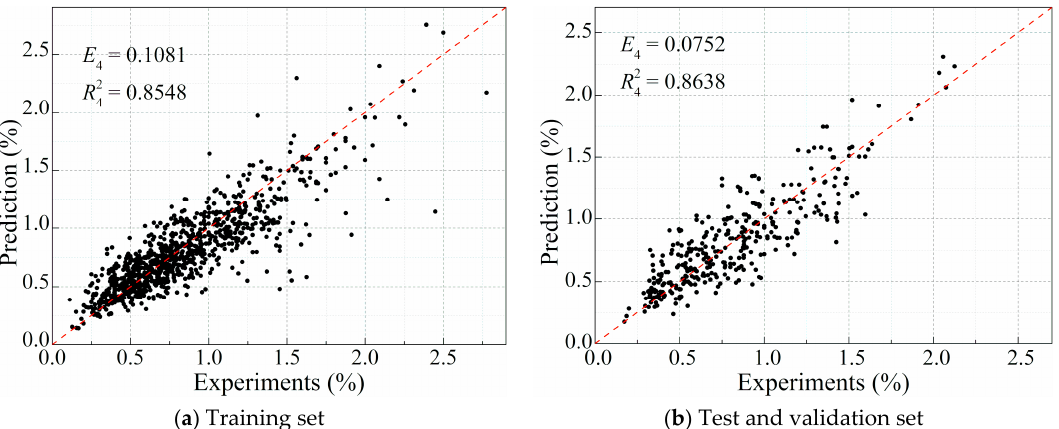
Figure 11. Comparison of experimental results of the yielding drifts and predicted results from the ANN model. ANN